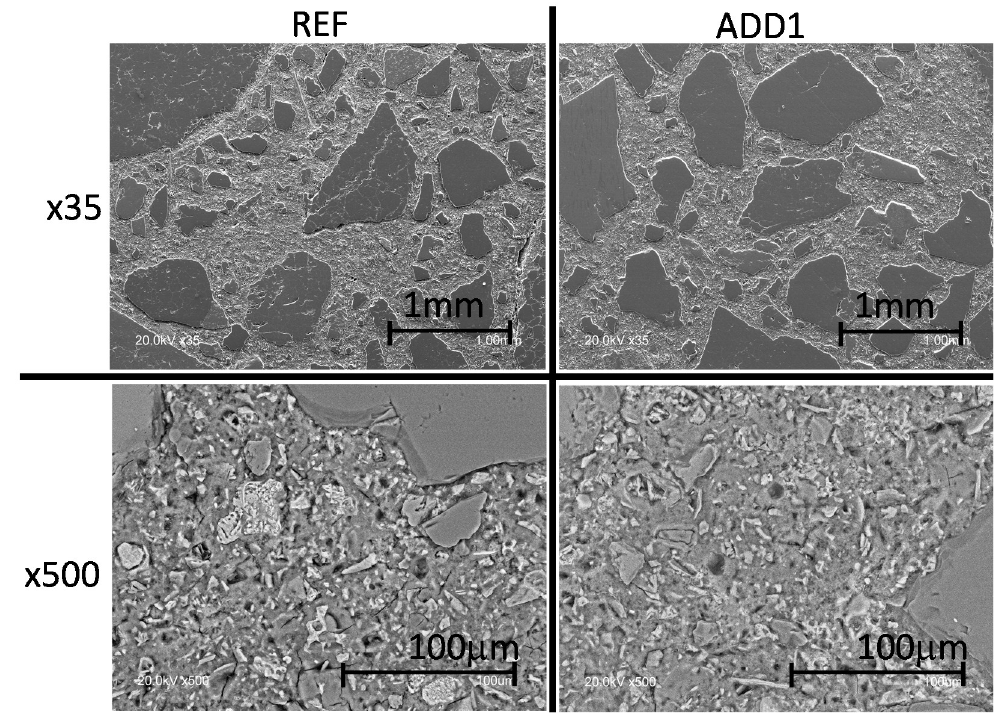
Figure 3. BSEM images: general aspect of REF (left) and Add1 (right) concrete after 90 days underwater.